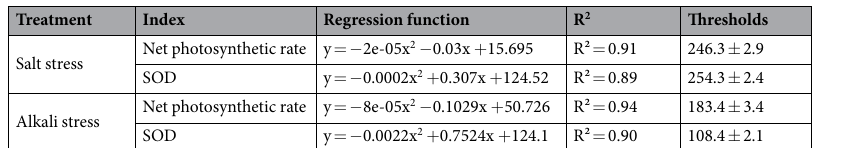
Table 2. Regression function of photosynthetic parameters, antioxidant system indices, and saline-alkali stress. Abbreviations: SOD: superoxide dismutase.